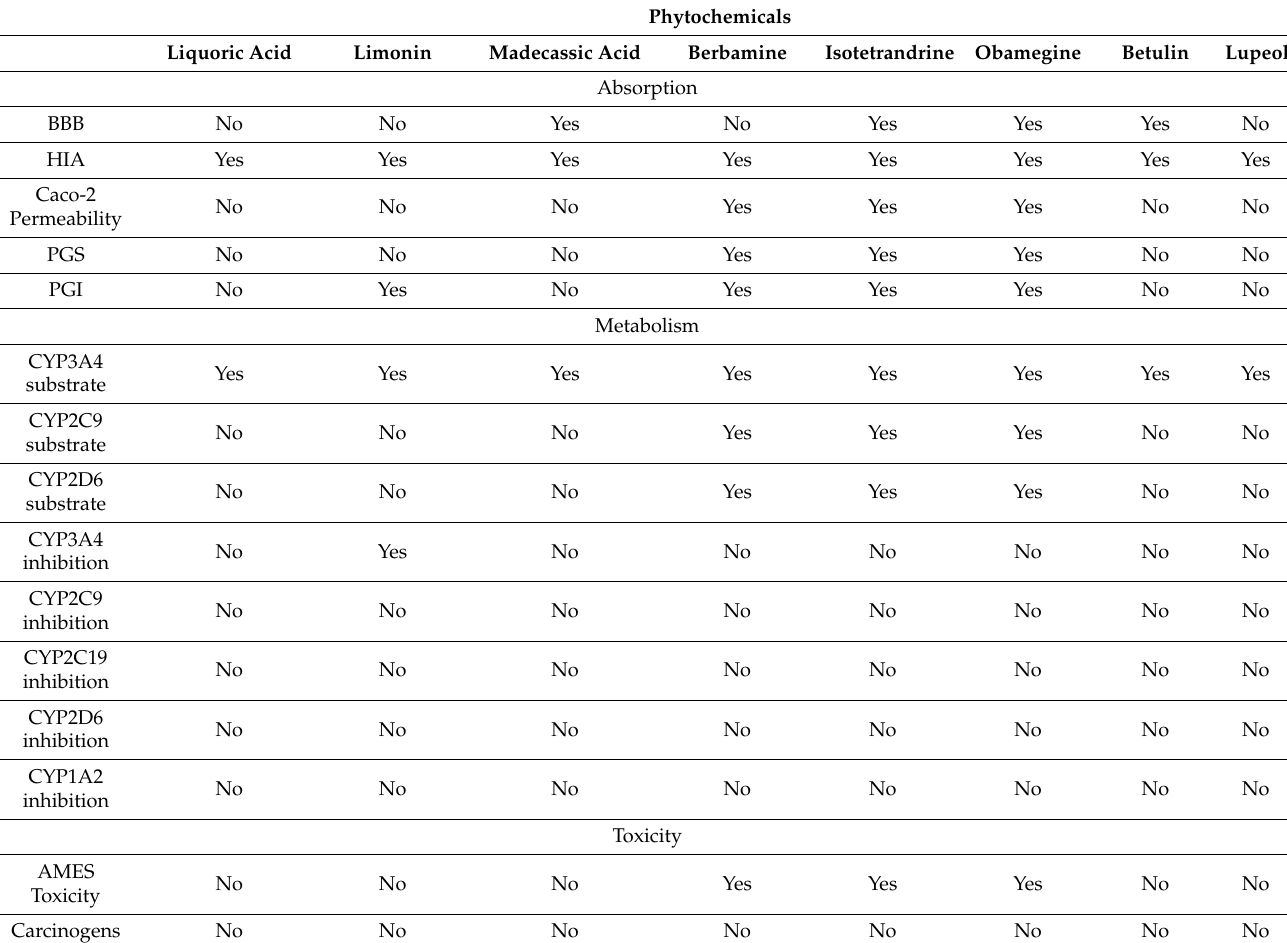
Table 3. ADMET-related drug-like parameters of the best-selected